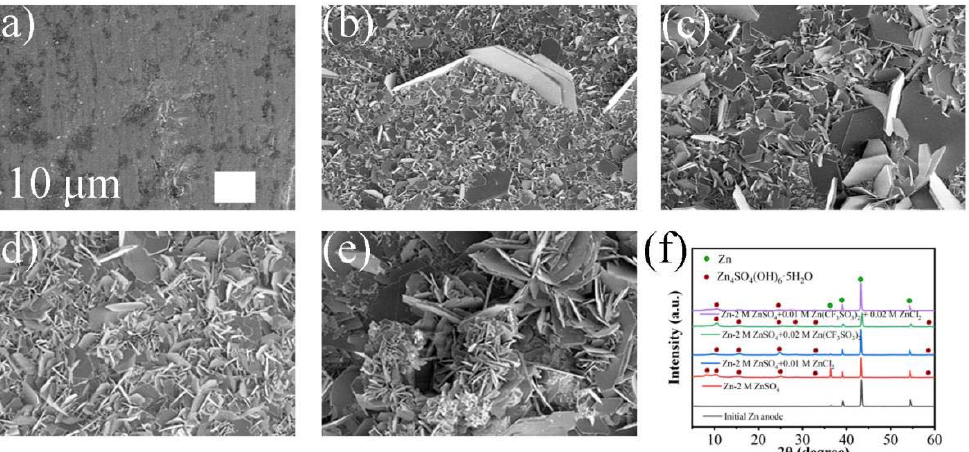
Figure 2. ( a ) Zinc foil; ( b ) Zinc anode in ZnSO 4 electrolyte; ( c ) Zinc anode in ZnSO 4 + ZnCl 2 electrolyte; ( d ) Zinc anode in ZnSO 4 + Zn(CF 3 SO 3 ) 2 electrolyte; ( e ) Zinc anode in ZnSO 4 + Zn(CF 3 SO 3 ) 2 + ZnCl 2 electrolyte; ( f ) XRD patterns of five zinc anodes.